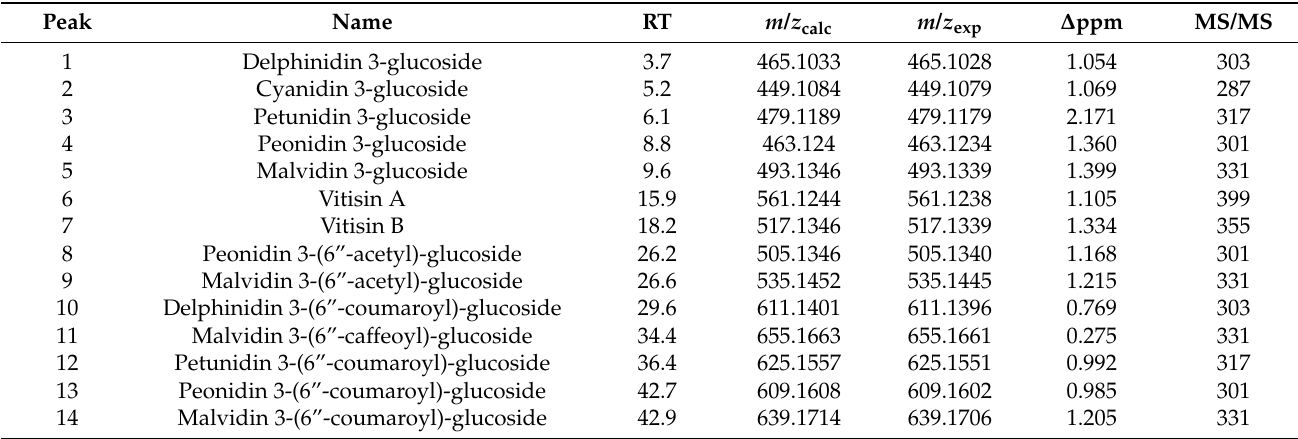
Table 6. LC-ESI-(+)-MS identification (positive ion mode) of the EtOH-H 2 O extract constituents. The peak numbers refer to those shown in Figure 5.